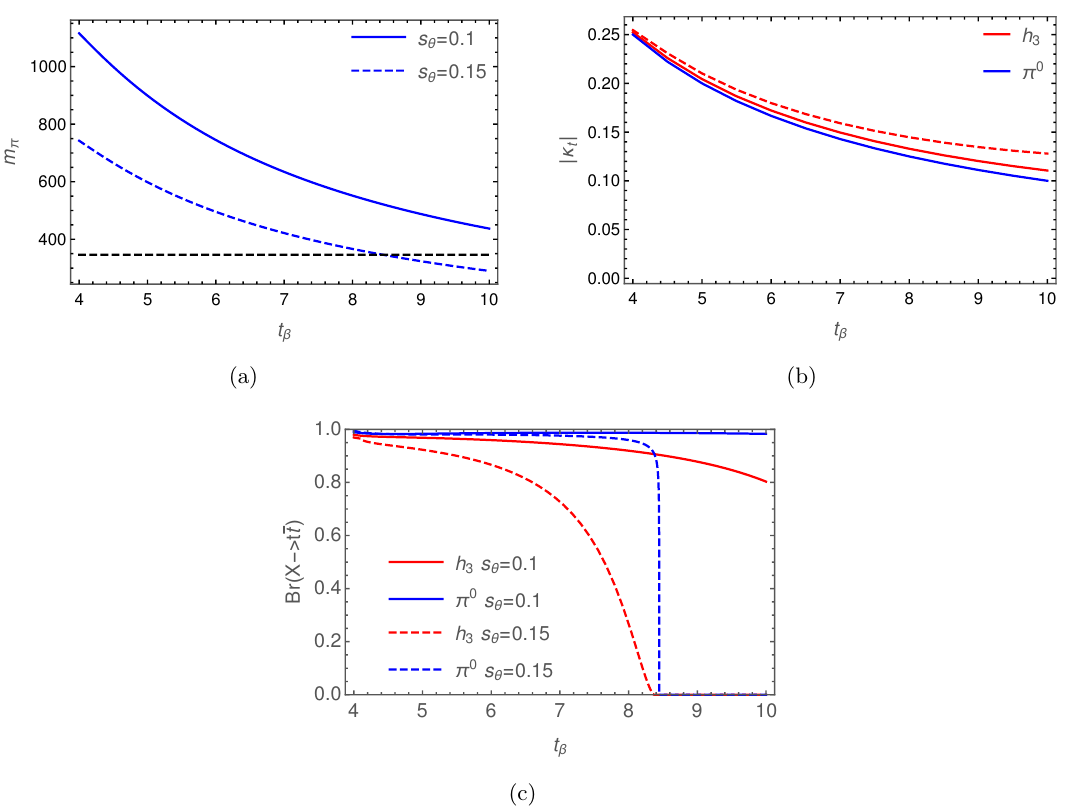
Figure 11 . (a) Mass of the (cid:25) 0 . The dashed horizontal line shows the t (cid:22) t threshold. (b) Reduced coupling to top quarks. (c) Branching ratio of h 3 and (cid:25) 0 to top-quark pair. In all panels (cid:21) (cid:8) = 0 : 15 and s (cid:18) = 0 : 1 (0 : 15) in the solid (dashed) lines.